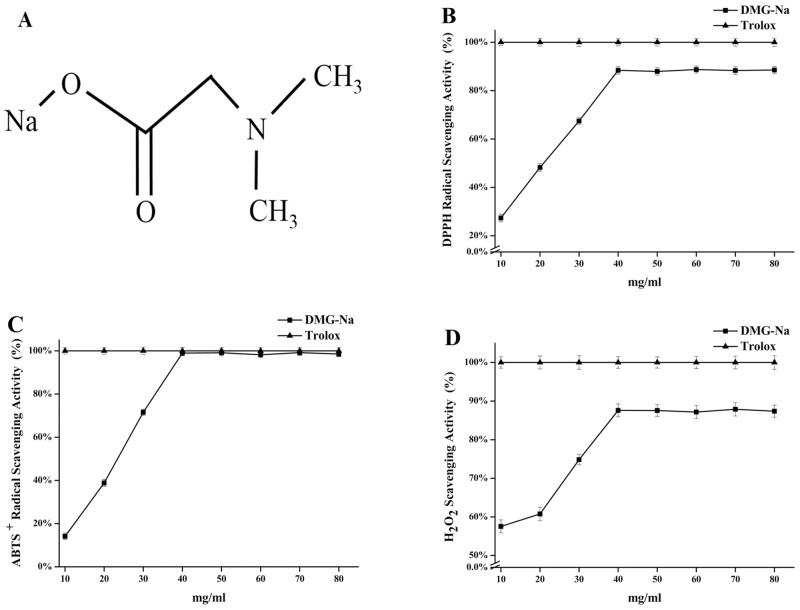
The structures of DMG-Na (Fig 1A), DPPH (Fig 1B), ABTS + (Fig 1C), and H2O2 (Fig 1D). Radical scavenging effects of DMG-Na and Trolox at 10–80 mg/ml.In panels 1B, 1C, and 1D, the values of the Trolox group is set to 100%. Values of DPPH and ABTS+ radical scavenging ability, and H2O2 scavenging ability are expressed as the mean ± SEM of three independent experiments. 1,1-diphenyl-2-pierylhydrazy (DPPH); 2,2'-Azinobis-(3-ethylbenzthiazoline-6- sulphonate) (ABTS+).